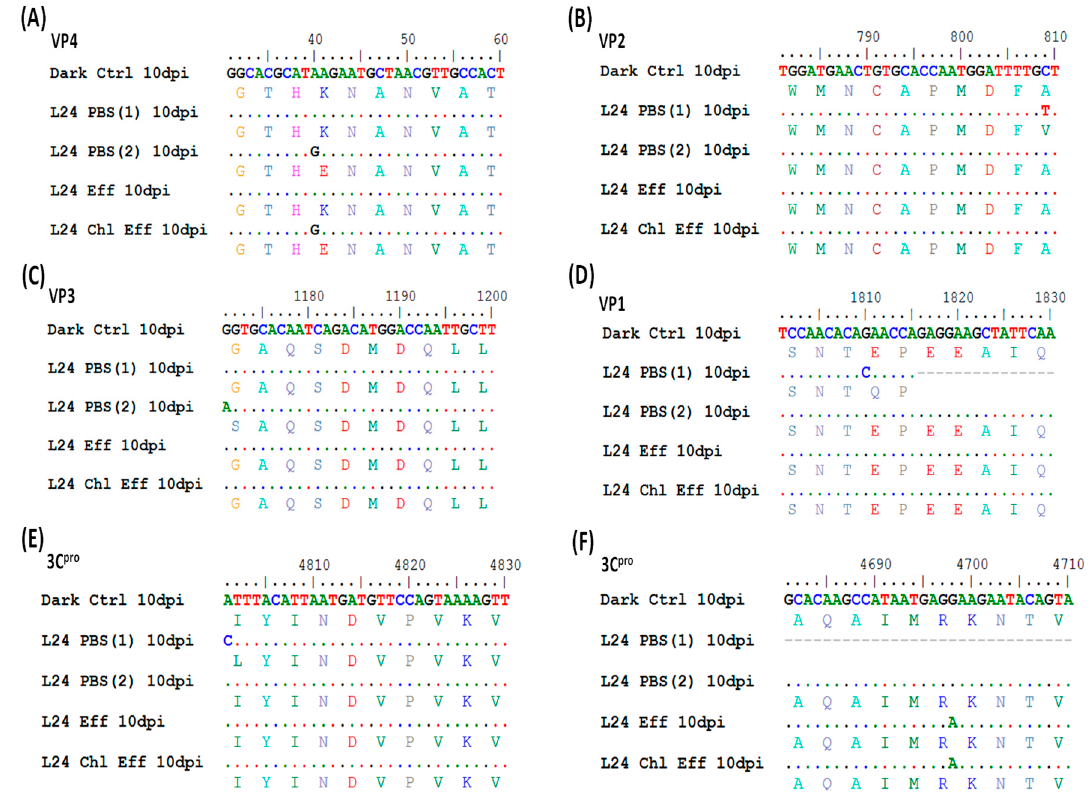
Figure 4. Genome sequence analysis of D24 and L24 (in PBS, effluent and chlorinated effluent) 10 days post-infection (dpi) in Vero cells. The nucleotide sequence of D24 in PBS is taken as the reference strain in this alignment (top row). The second (and other even-numbered) rows represent the predicted amino acid sequence. Identical nucleotide sequences are represented by a dot ( . ). Six nonsynonymous mutations were observed in the genes coding for ( A ) VP4, ( B ) VP2, ( C ) VP3, ( D ) VP1, and ( E , F ) 3C pro . The number of experiments performed was n = 2 for EV70 in PBS, n = 1 in effluent (Eff) and n = 1 in chlorinated effluent (Chl Eff). Sequence data could only be obtained from one experimental run for solar inactivation in wastewater matrices. Scale (top row) represents the nucleotide sequence of EV70 strain J670/71 (from NCBI reference D00820), with position 1 corresponding to the first nucleotide of the open reading frame.